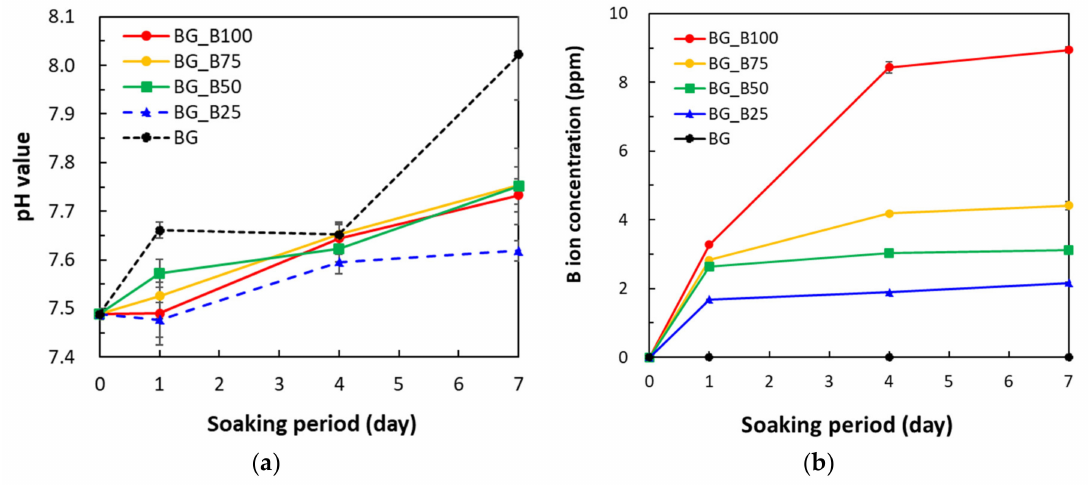
Figure 3. ( a ) pH value and ( b ) boron ions released into SBF after BG and B-doped BG soaking for 7